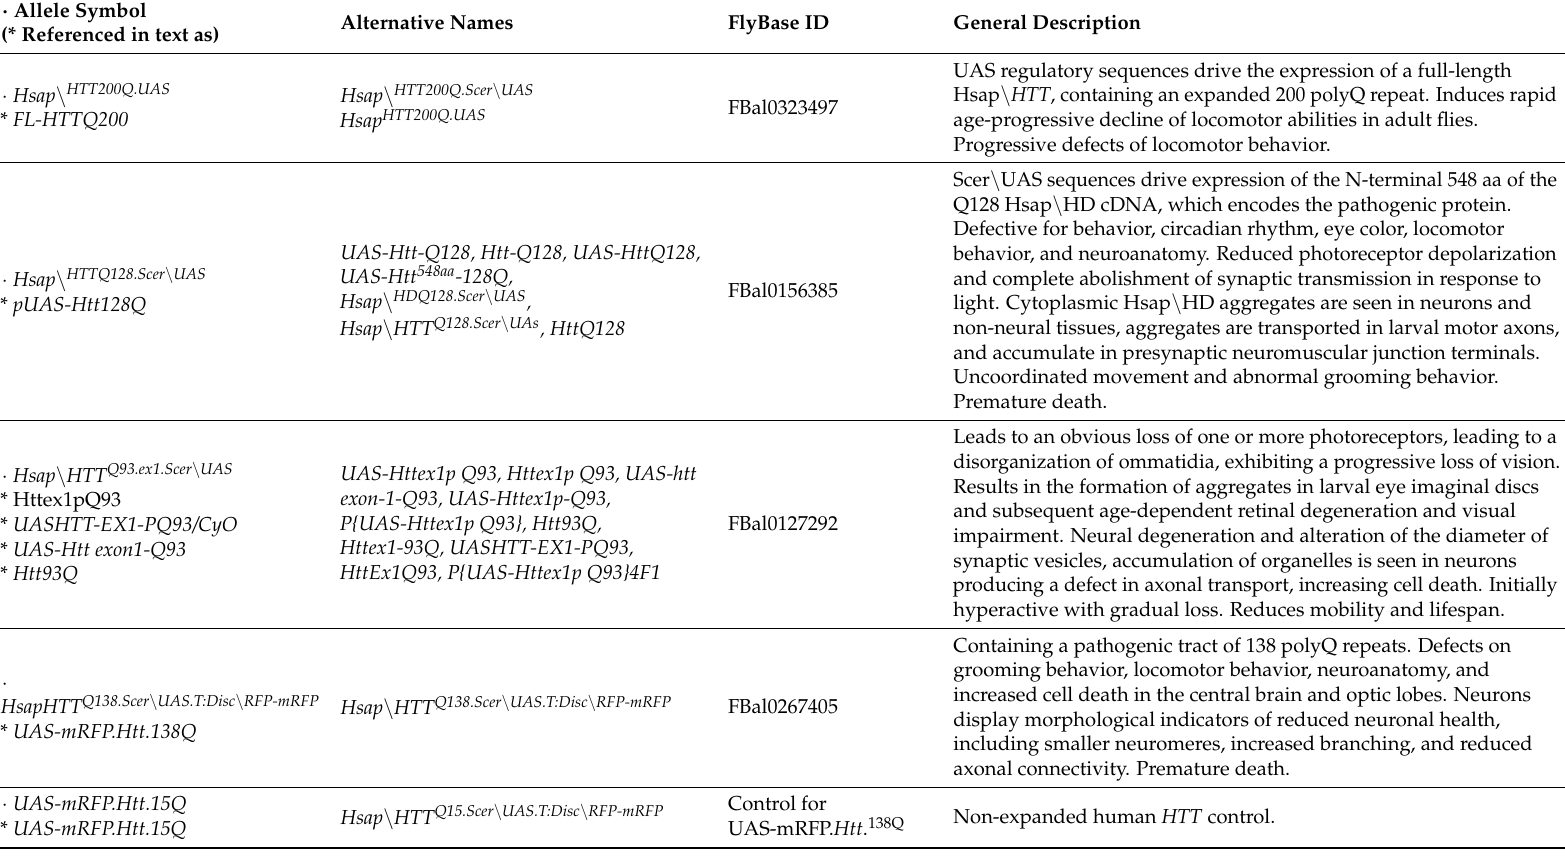
Table 1. Drosophila mutants named in Section 7. UAS—upstream activating sequence; UCP—uncoupled protein; HTT —huntingtin; CAG—cytosine–adenine–guanine; HD—Huntington’s disease; * Referenced in text